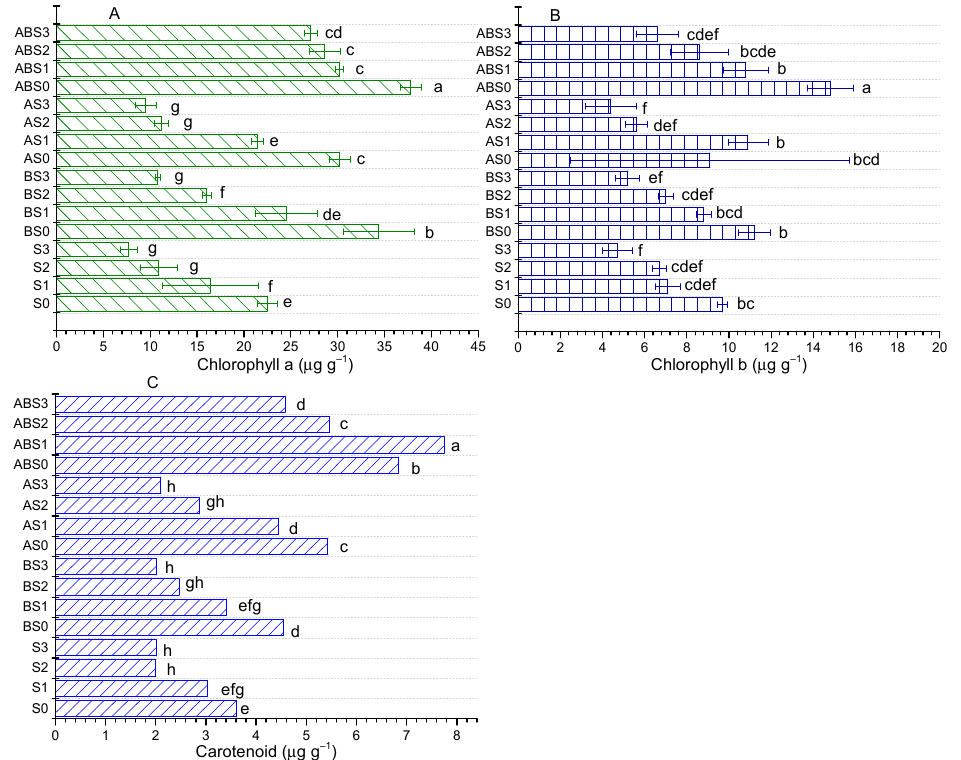
Figure 5 . Effect of biochar and AMF on photosynthetic pigments: ( A ) Chlorophyll a; ( B ) Chlorophyll b; ( C ) Carotenoid. Data present the mean ± standard deviation of three replicates and mean values followed by different letters are significantly different at p < 0.05 according to Duncan multiple range test. The significance of acronyms is the same as in Figure 1.